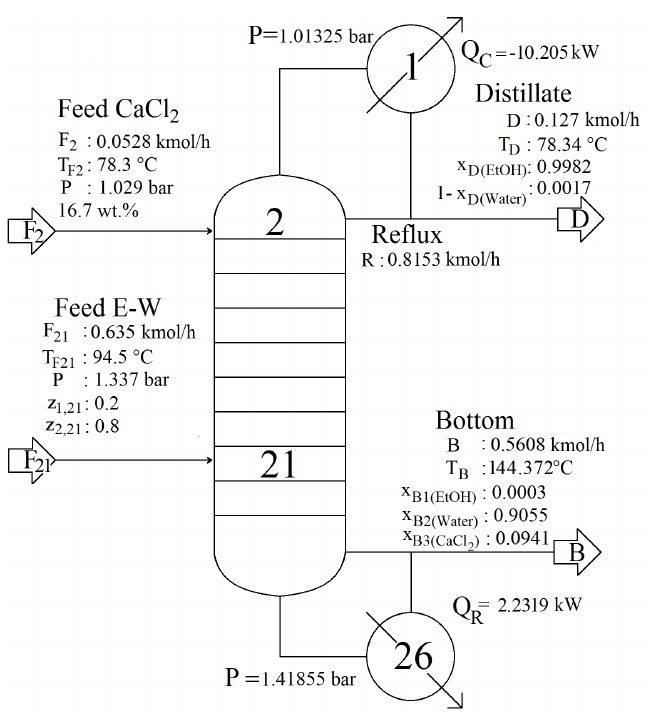
Figure 1. Ideal operating conditions of the saline extractive distillation